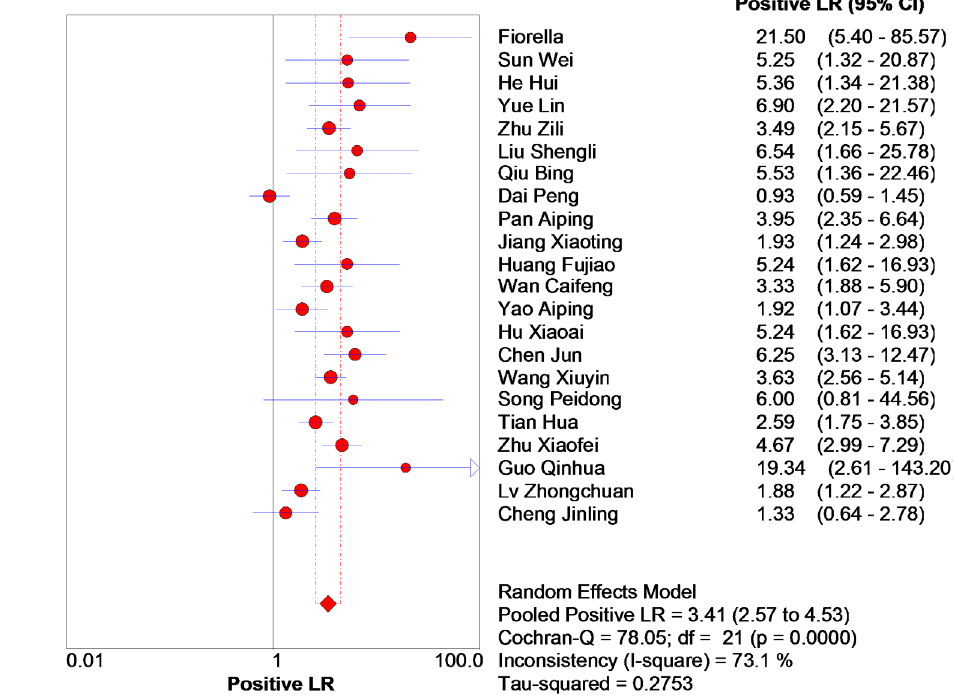
Figure 4: The diagnostic specificity of serum CA72-4 in the diagnosis of colorectal cancer